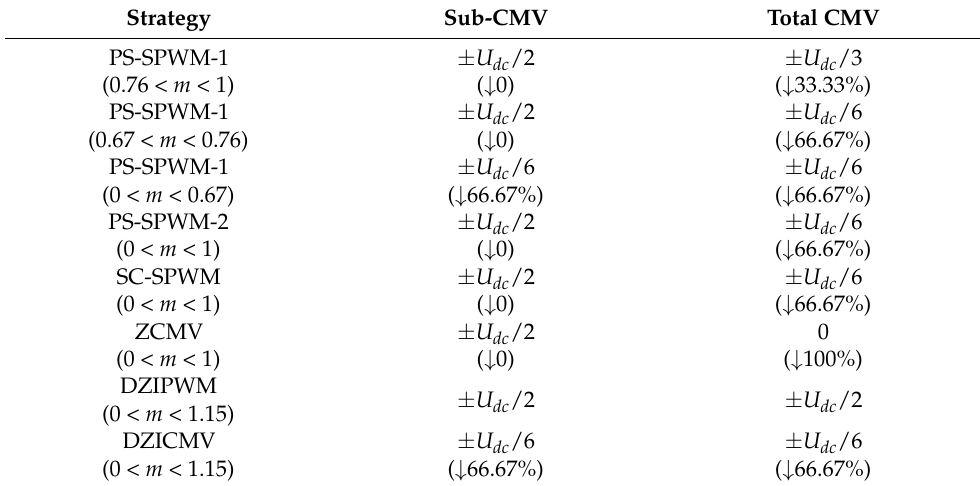
Table 5. The CMV peak values and the percentage of